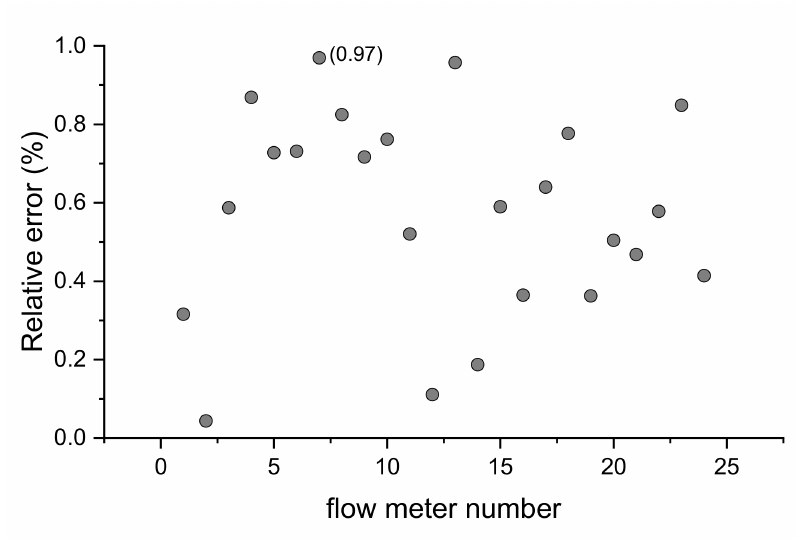
Figure 13. Relative error between observed and expected flow rates.